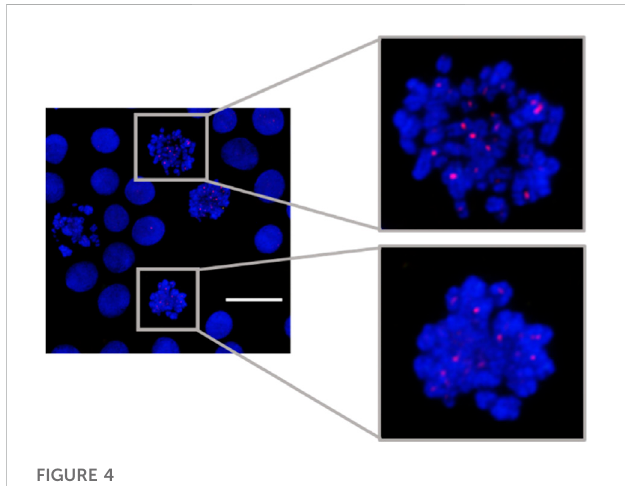
FIGURE 4 MeFISH images of α -sat (red) in HepG2 cells. The nuclei were labelled by DAPI (blue). Scale bar, 20 μ m.